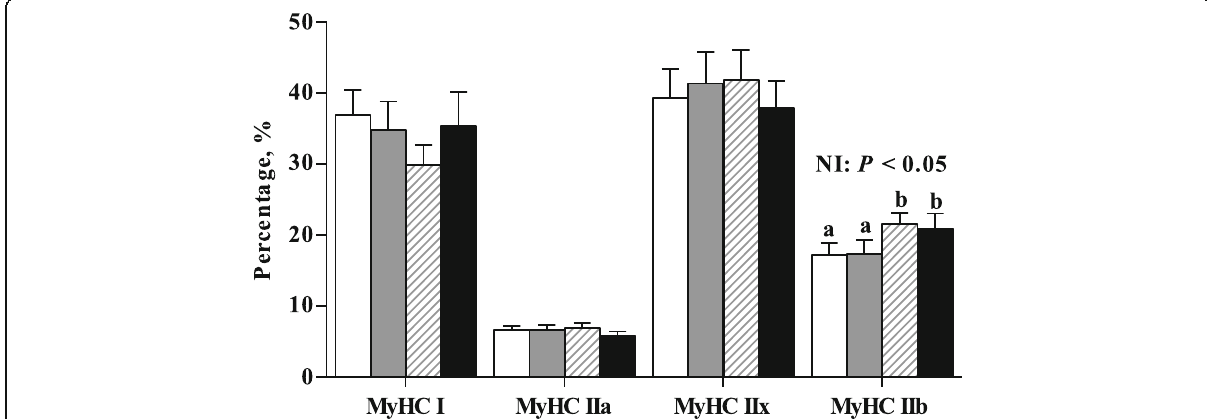
Fig. 3 Effects of the level of nutrient intake on the percentage of MyHC in psoas major muscle of pigs with different birth weights. Values are means, with their standard errors represented by vertical bars ( n = 6 for each group). Mean values with different letters (a, b) were significantly different between four groups ( P <